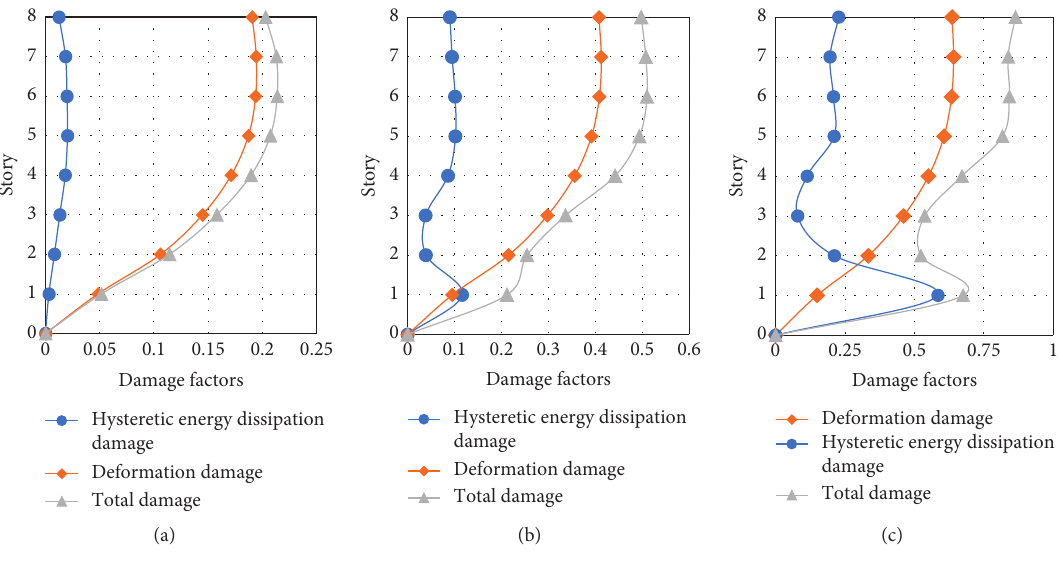
Figure 11: The damage factors of stories. (a) PGA � 0.2 g. (b) PGA � 0.4 g. (c) PGA � 0.6g. Table 4: Comparison of damage factors on the first story.